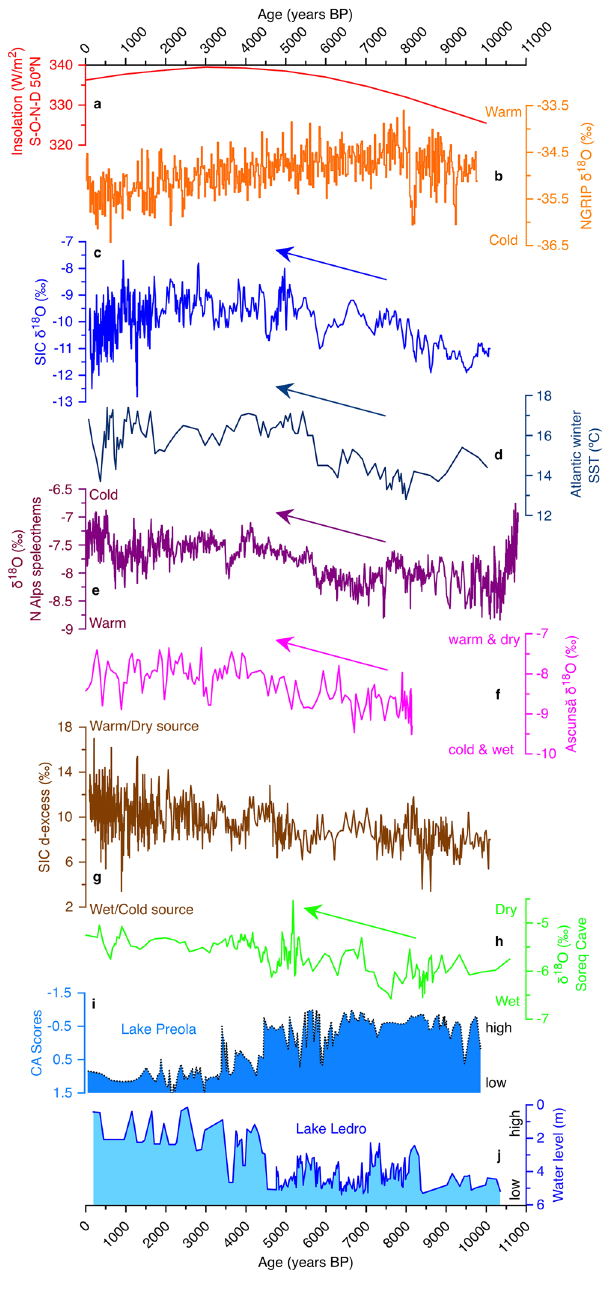
Figure 3. SIC δ 18 O (proxy for autumn through early winter (SOND) temperature) and d-excess (proxy for moisture source) against Northern Hemisphere paleoclimate proxies. ( a ) Insolation during SOND at 50°N 36 . ( b ) NGRIP ice core δ 18 O 37 . ( c ) SIC δ 18 O (this study). ( d ) Atlantic winter sea surface temperature (SST) 38 . ( e ) North Alps speleothem δ 18 O-based winter temperature 39 . ( f ) SW Romania speleothem δ 18 O 7 . ( g ) SIC d-excess record (this study). ( h ) Speleothem δ 18 O in Soreq Cave 31 . ( i ) CA scores (lake level proxy) 26 at Preola, S Italy, 37°N. ( j ) Water level 26 at Lake Ledro, N Italy,